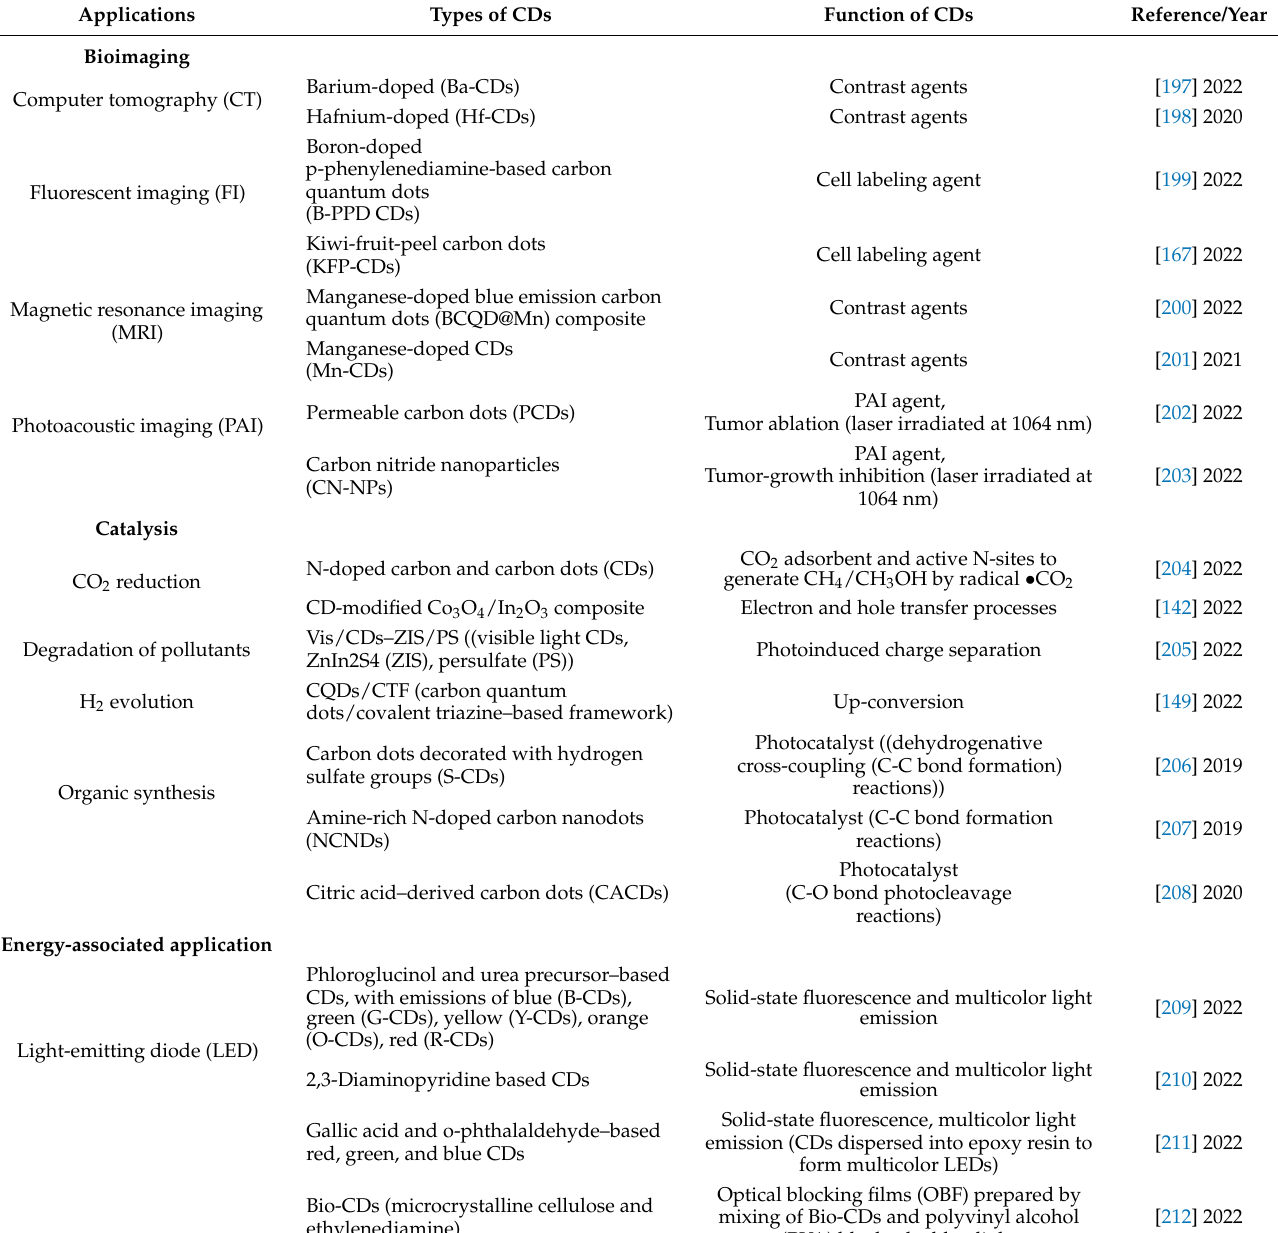
Table 3. Possible applications of various CDs and their